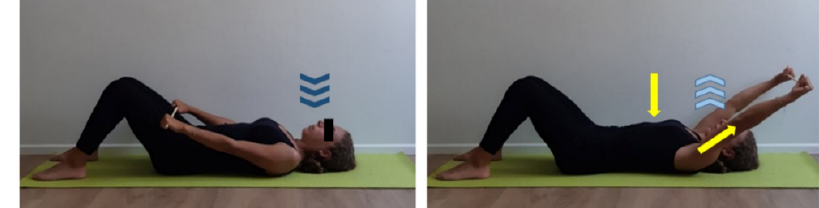
touch with the floor without lifting thorax (yellow arrow). Three sets of 10 repetitions, 30 s recovery.